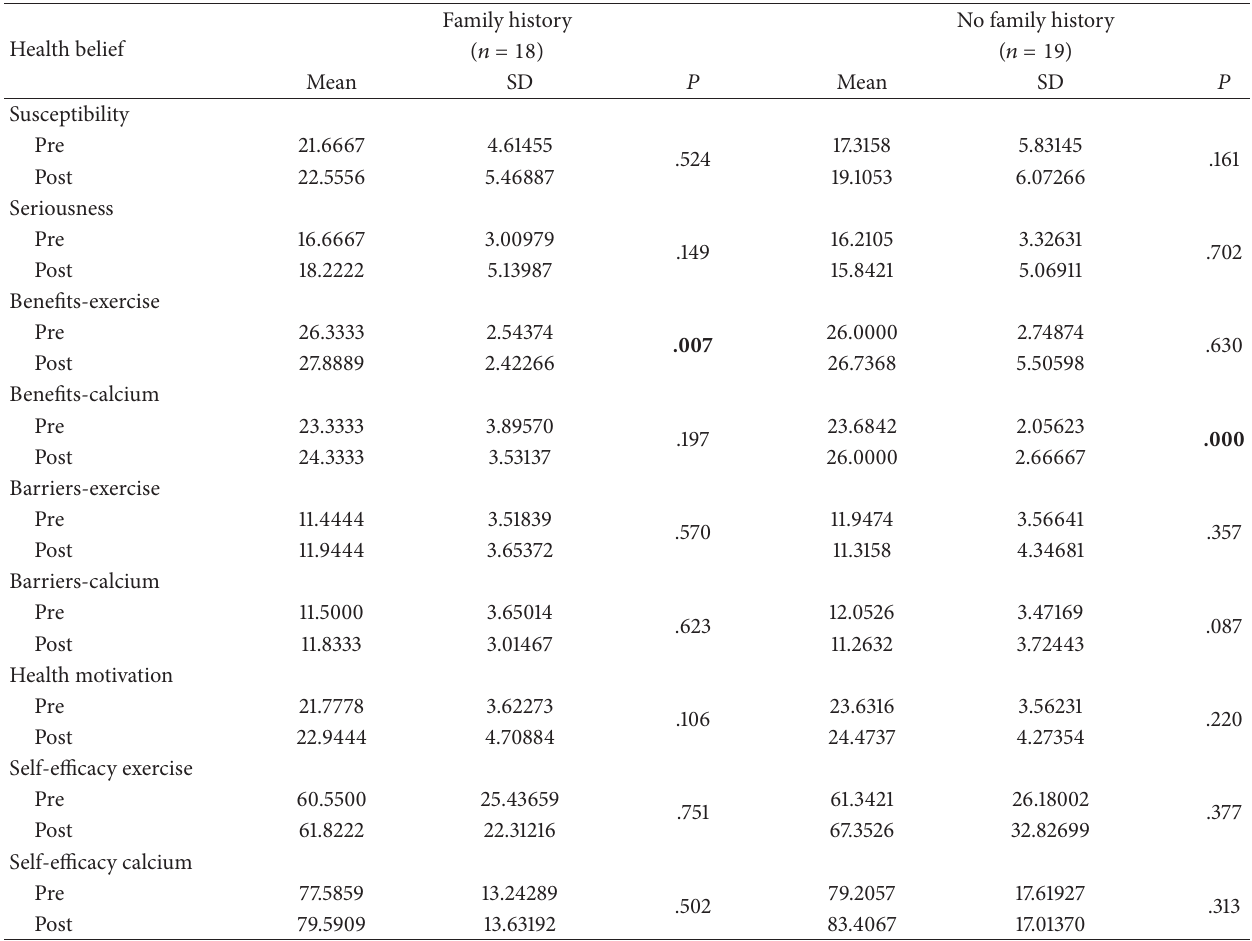
Table 3: Health beliefs and self-efficacy